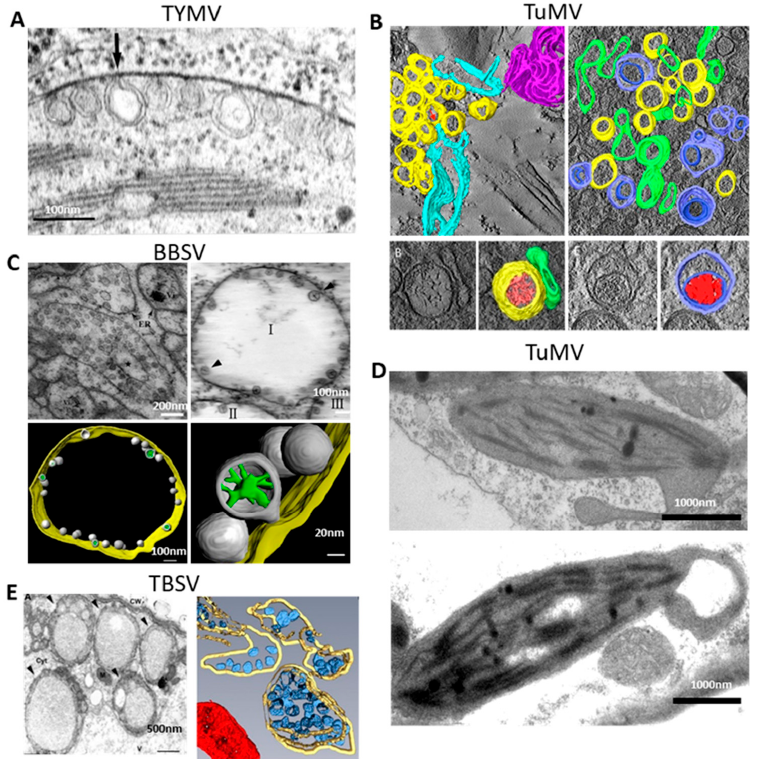
Figure 1. Virus-induced membranous structures derived from organellar membranes. ( A ) Electron micrograph of an ultrathin section of part of a chloroplast from TYMV-infected Chinese cabbage leaf cell. The arrow points to a vesicle in which an open channel is connecting the interior to the cytoplasm. Adapted from [69]. ( B ) Three-dimensional reconstruction of TuMV-induced membrane rearrangement. Overview of tomogram slice from TuMV-infected vascular parenchymal cell at the mid stage (upper left) and late stage (upper right) of infection. Three-dimensional model of a single-membrane tubule (SMT) with fibrillary material inside and with an adjacent intermediate tubular structure (lower left). Three-dimensional model of a double-membrane tubule (DMT) with a core of electron-dense materials inside (lower right). Yellow, SMTs; light red, electron-dense materials; green, intermediate tubular structures; light blue, outer membranes of DMTs; dark blue, inner membranes of DMTs; dark red, the electron-dense materials inside DMTs; sky blue, rough ER; magenta, cytoplasmic inclusion body; red arrow, connection between the rough ER membrane and an SMT. Adapted with permission from [47]. ( C ) Transmission electron microcopy (TEM) analysis and 3D model of BBSV-induced ER membrane rearrangements. (Upper left) BBSV-induced vesiculation of the ER. Vesicle packets were observed in the aggregates of branched ER cisternae (*). Black arrowheads, ER membrane; Vi, virus crystal. (Upper right) Tomographic slice of BBSV-induced vesicle packets and ER-derived spherules. I II and III represent different units of VPs. (Lower left) Three-dimensional model of BBSV-induced vesicle packets and ER-derived spherules. (Lower right) Enlargement of the connections between the spherules and the outer ER membrane. Gold, outer ER membrane; gray, BBSV-induced spherules; green, fibrillary materials inside the spherules. Adapted with permission from [45]. ( D ) TEM analysis of abnormally distorted chloroplasts in TuMV-infected leaves. (Upper panel) Chloroplast with membrane-bound extrusion. (Lower panel) Amoeboid shaping of chloroplasts, showing the extrusion of chloroplast encircling a large vesicle. Adapted with permission from [71]. ( E ) Electron analysis and 3D model of TBSV replication platform. (Left) Transmission electron micrograph of a TBSV-infected N. benthamiana leaf cell. Arrowheads, TBSV- induced individual peroxisomal multivesicular bodies (MVBs). Adapted with permission from [62]. (Right) Three-dimensional model of TBSV replication platform in yeast showing peripheral MVB with characteristic spherules. Yellow, peroxisome membrane; blue, spherules; red, mitochondrion. Adapted with permission from